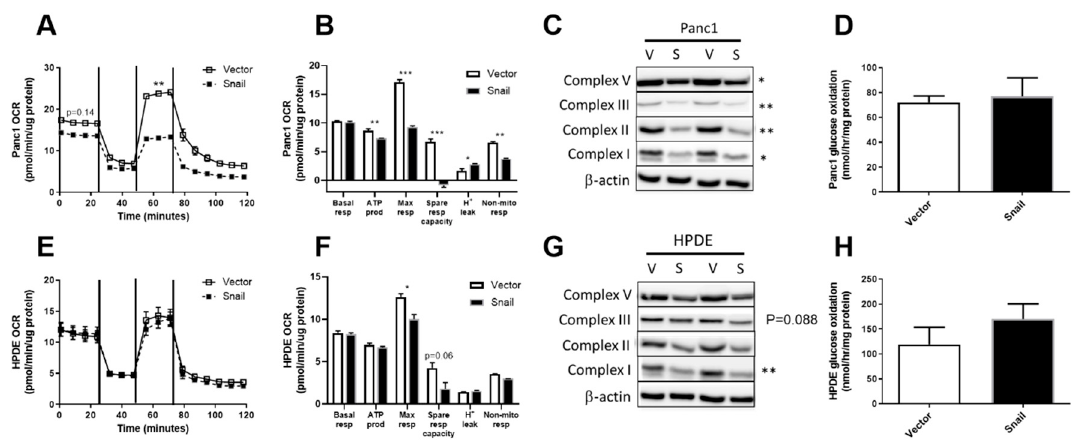
Figure 5. E ff ects of Snail overexpression on oxidative metabolism in Panc1 and HPDE cells. ( A , E ) Oxygen consumption rate (OCR) was measured using the Seahorse XF96 Analyzer at basal levels for 30 min followed by sequential injections of 1 µ M oligomycin, 0.5 µ M Carbonyl cyanide-4-(trifluoromethoxy)-phenylhydrazone (FCCP) and 1 µ M rotenone at 30 min intervals. Basal and maximal (following FCCP injection) values of OCR from the time-course data were used for statistical analysis. ( B , F ) Basal respiration, ATP production, maximal respiration, spare respiratory capacity, proton leak and non-mitochondrial respiration calculated from Seahorse trace data for Panc1 and HPDE cells respectively. ( C , G ) Immunoblotting results for ETC complex I, II, III, V antibodies, with β -actin used as loading control. Densitometry on western blots was performed using image J. ( D , H ) Glucose oxidation was measured using the U- 14 C-Glucose tracer over one-hour period. Results are shown as mean ± SEM with n = 3. * p < 0.05, ** p < 0.01 for di ff erence between vector control and Snail-overexpressing cells.